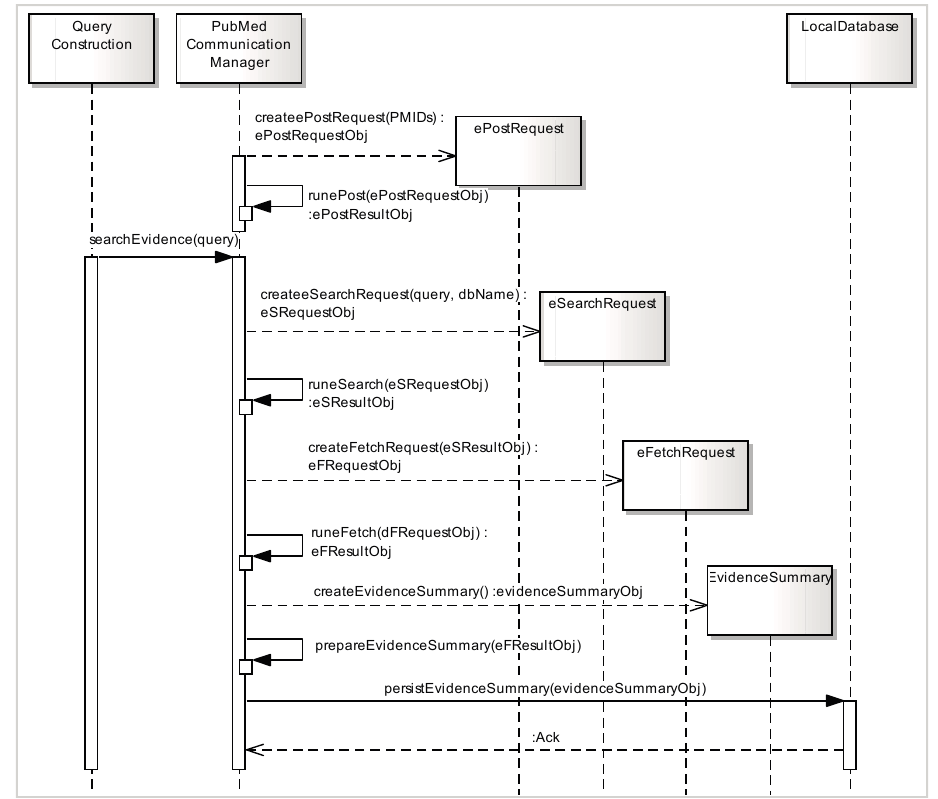
Figure 4. Sequence diagram of eUtils API functions (ePost, eSearch, and eFetch) used as a part of the query execution function for creation of meta-data associated with evidence.